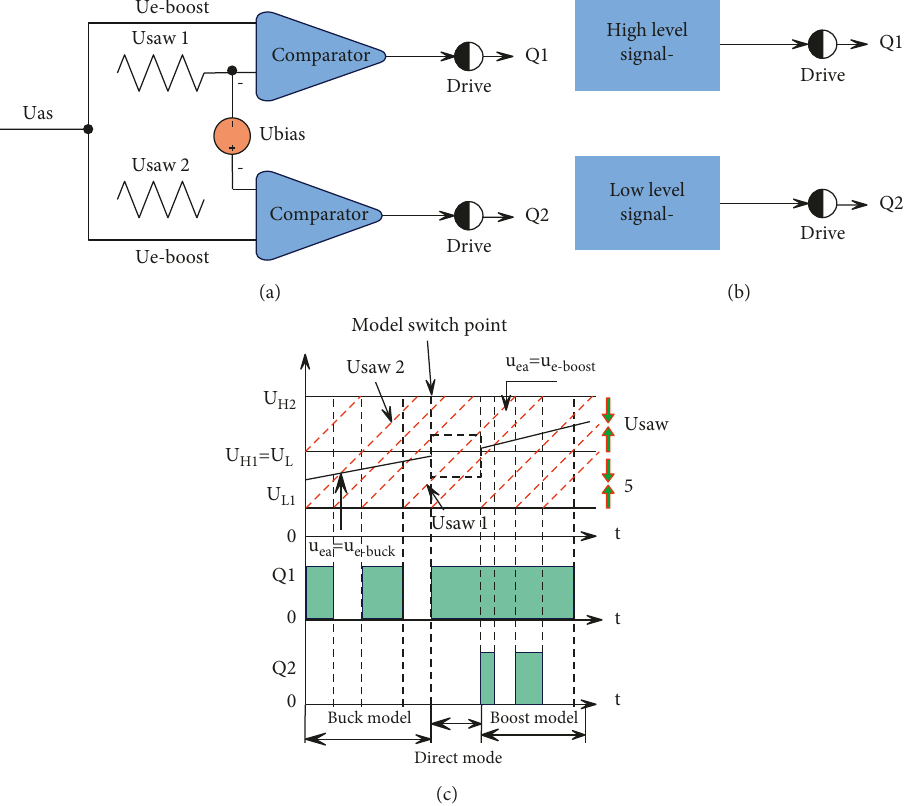
Figure 2: The three-mode control mode of the double-tube buck-boost power conversion circuit: (a) schematic diagram of the non-pass- through mode control strategy; (b) schematic diagram of the direct mode control strategy; (c) main working